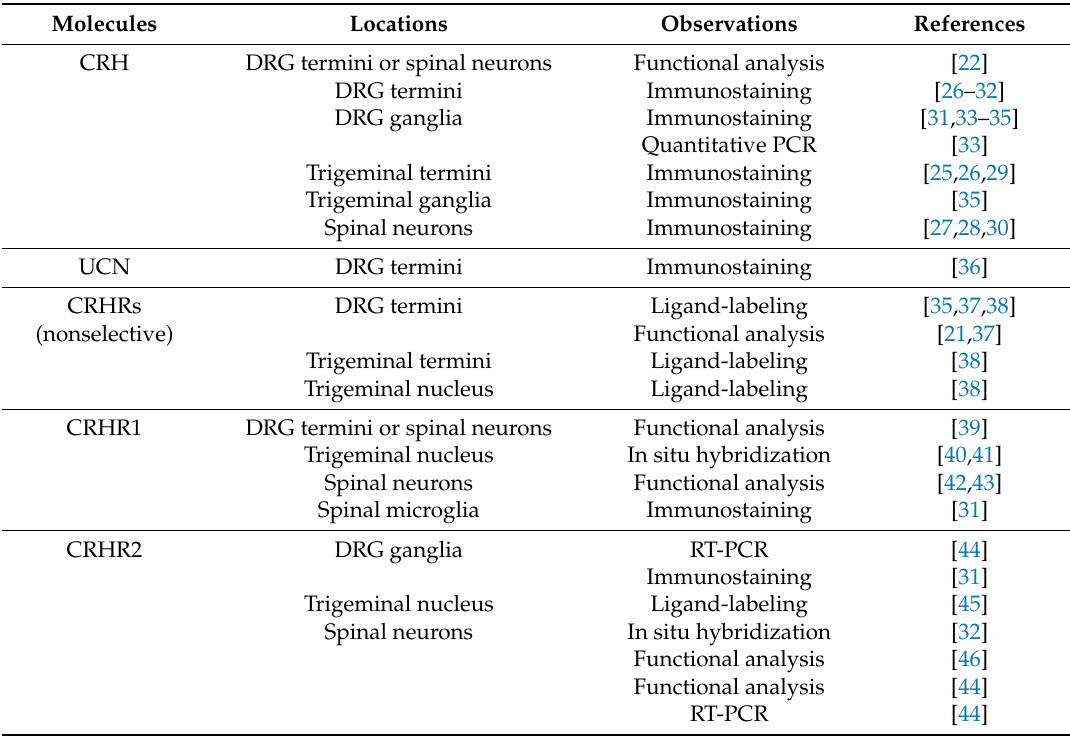
Table 1. Expressions of corticotropin-releasing hormone (CRH) and CRH receptors (CRHRs) in dorsal root ganglia (DRG) and related components mentioned in this review. Abbreviations: UCN, urocortins; RT-PCR, reverse transcriptase-polymerase chain